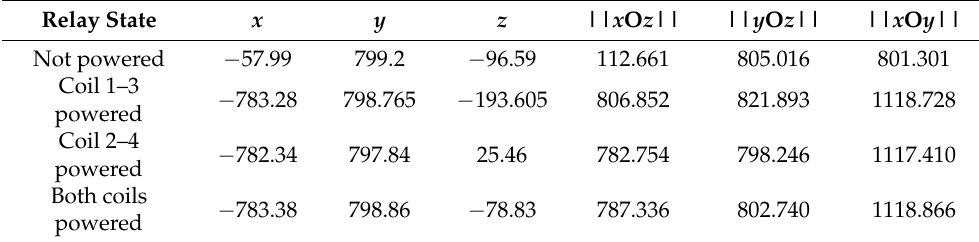
Table 2. Induction (µT) determined for measuring point 333.